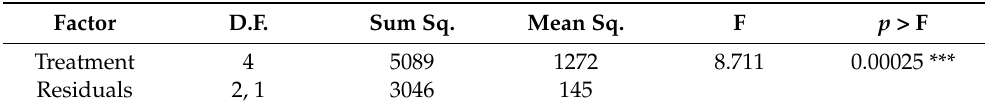
Table 1. Overall ANOVA comparing effect of 0, 1, 2 and 3 months of preconditioning by leaching and unit-restricted microfungal colonization on subsequent Basidiomycete fungal attachment, with and without sterilization by gamma-irradiation after 0 and 3 months preconditioning. Factor D.F. Sum Sq. Mean Sq. Residuals 2, 1